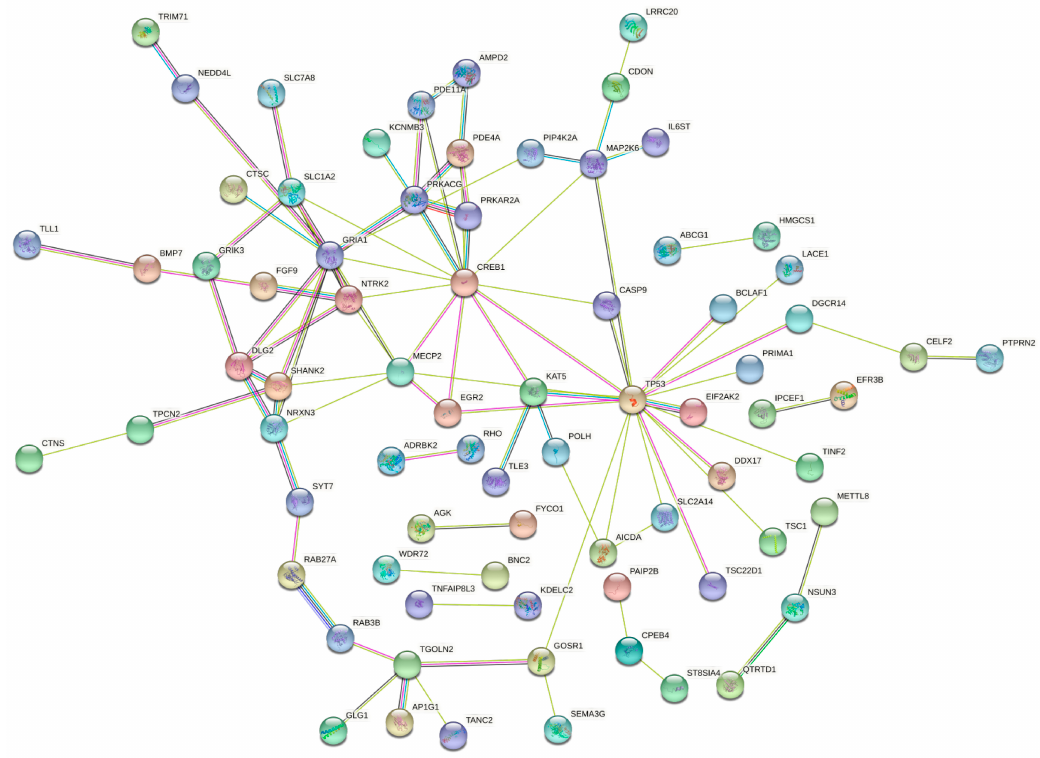
Figure 4. STRING protein interaction network of 75 out of 147 genes targeted by both hsa-miR-133a-3p and hsa-miR-375-3p.